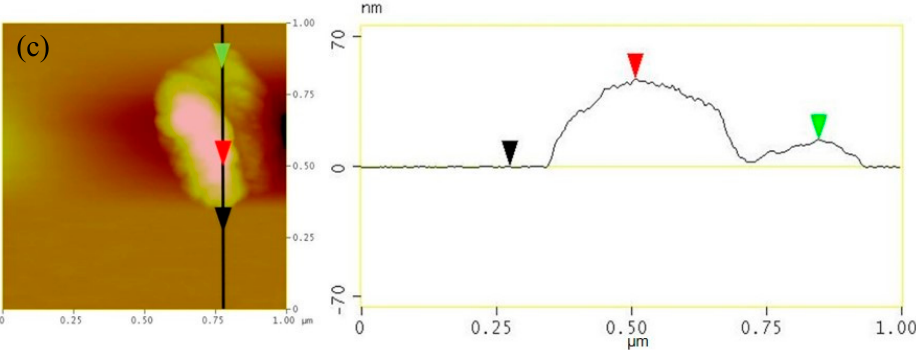
Figure 2. AFM images and corresponding height profiles of ( a ) GO, ( b ) GO- g -PTA-F, and ( c ) GO- g